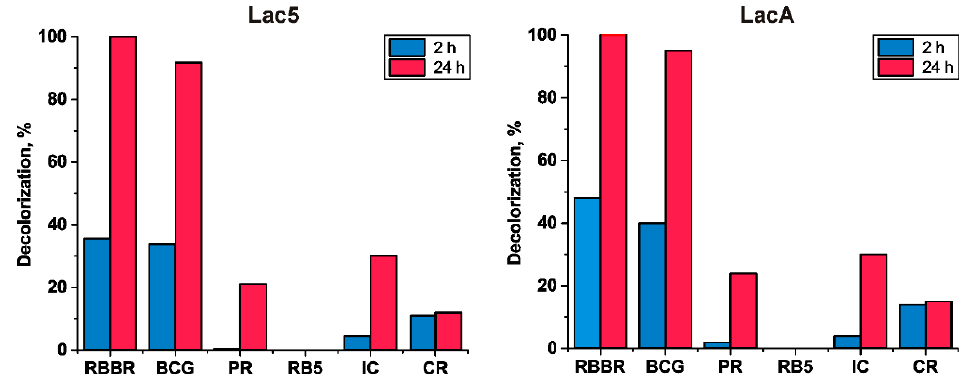
Figure 3. Decolorization of different dyes by P. lycii laccases. RBBR—Remazol Brilliant Blue R, BCG—Bromocresol Green, PR—Phenol Red, RB5—Reactive Black 5, IC—Indigo Carmine, CR—Congo Red.